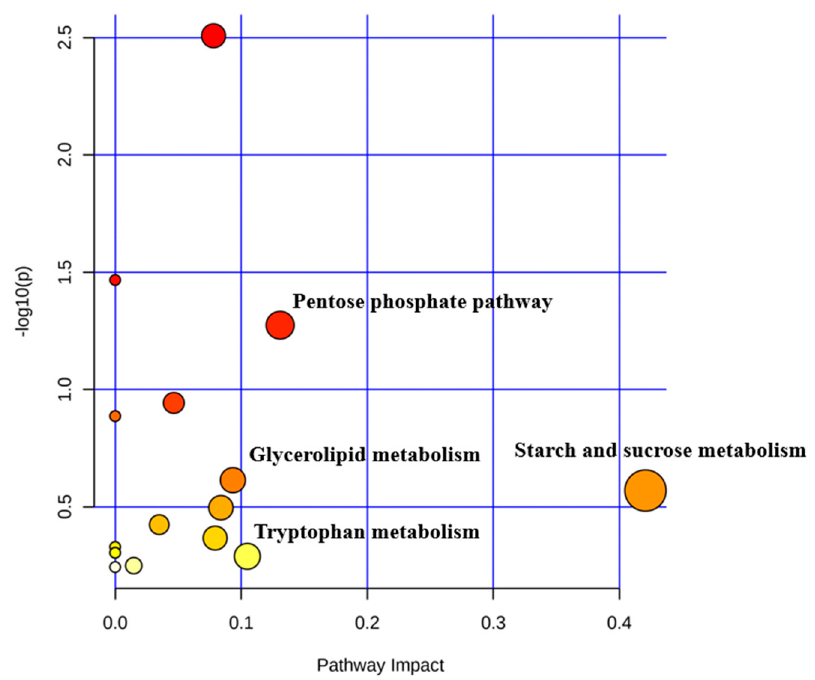
Figure 6. The significant metabolic pathways characterized in rumen fluid in CON and DAN group.